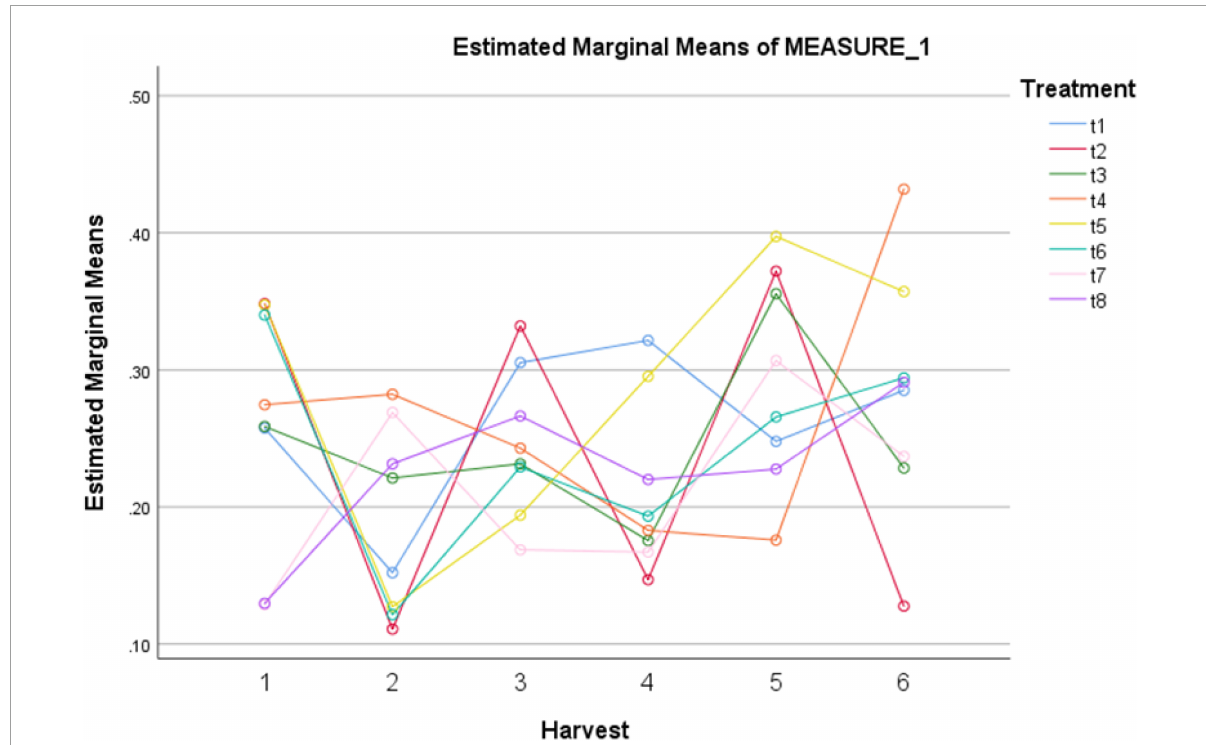
FIGURE3 Effect of different treatments of elicitors on total phenolic content of Silybum marianum in hydroponics. The harvest time is on x -axis; 1 = 24 h, 2 = 48 h, 3 = 72 h, 4 = 96 h, 5 = 120 h, 6 = 144 h. For different treatments, t1 = control, t2 = methyl jasmonate, t3 = silver nanoparticles, t4 = fungal elicitors, t5 = methyl jasmonate + fungal elicitors, t6 = methyl jasmonate + silver nanoparticles, t7 = fungal elicitors + Silver nanoparticles, t8 = methyl jasmonate + silver nanoparticles + fungal